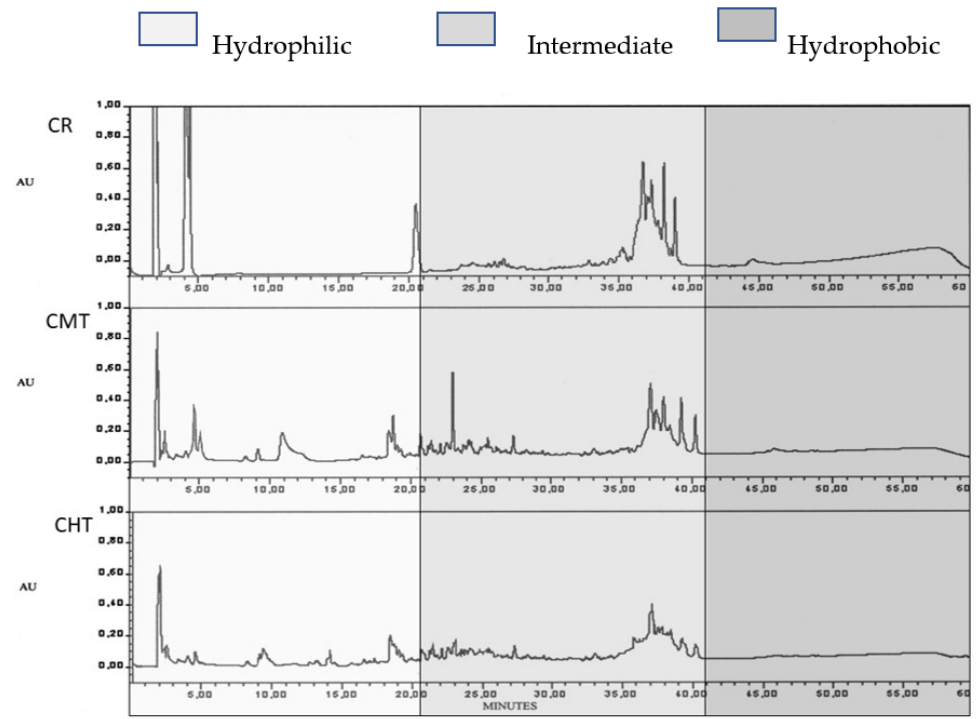
Figure 8. RP-HPLC of the soluble nitrogen fraction of Canestrato Pugliese cheese made from raw and thermized milk at 300 days of ripening. CR = raw milk cheese; CMT = mild-thermized cheese; CHT = high-thermized cheese.